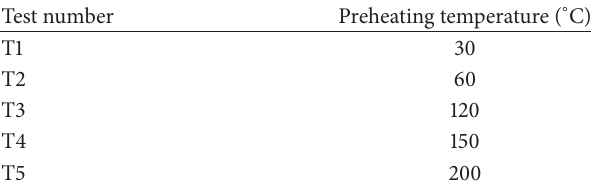
Table 2: Summary of different test cases.